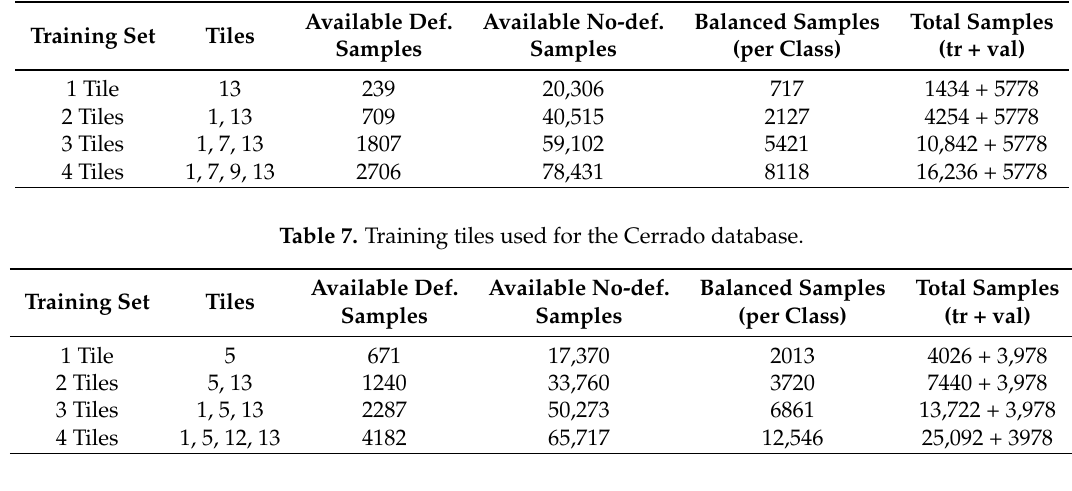
Table 6. Training tiles used for the Amazon database.